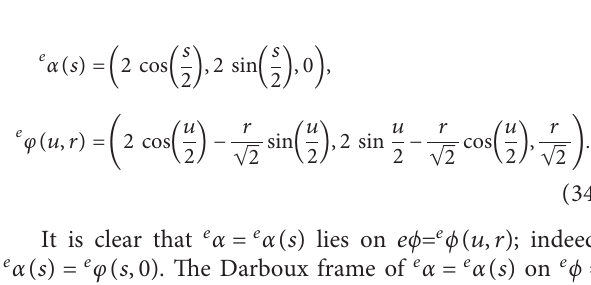
Figure 3: gn -Smarandache ruled surface